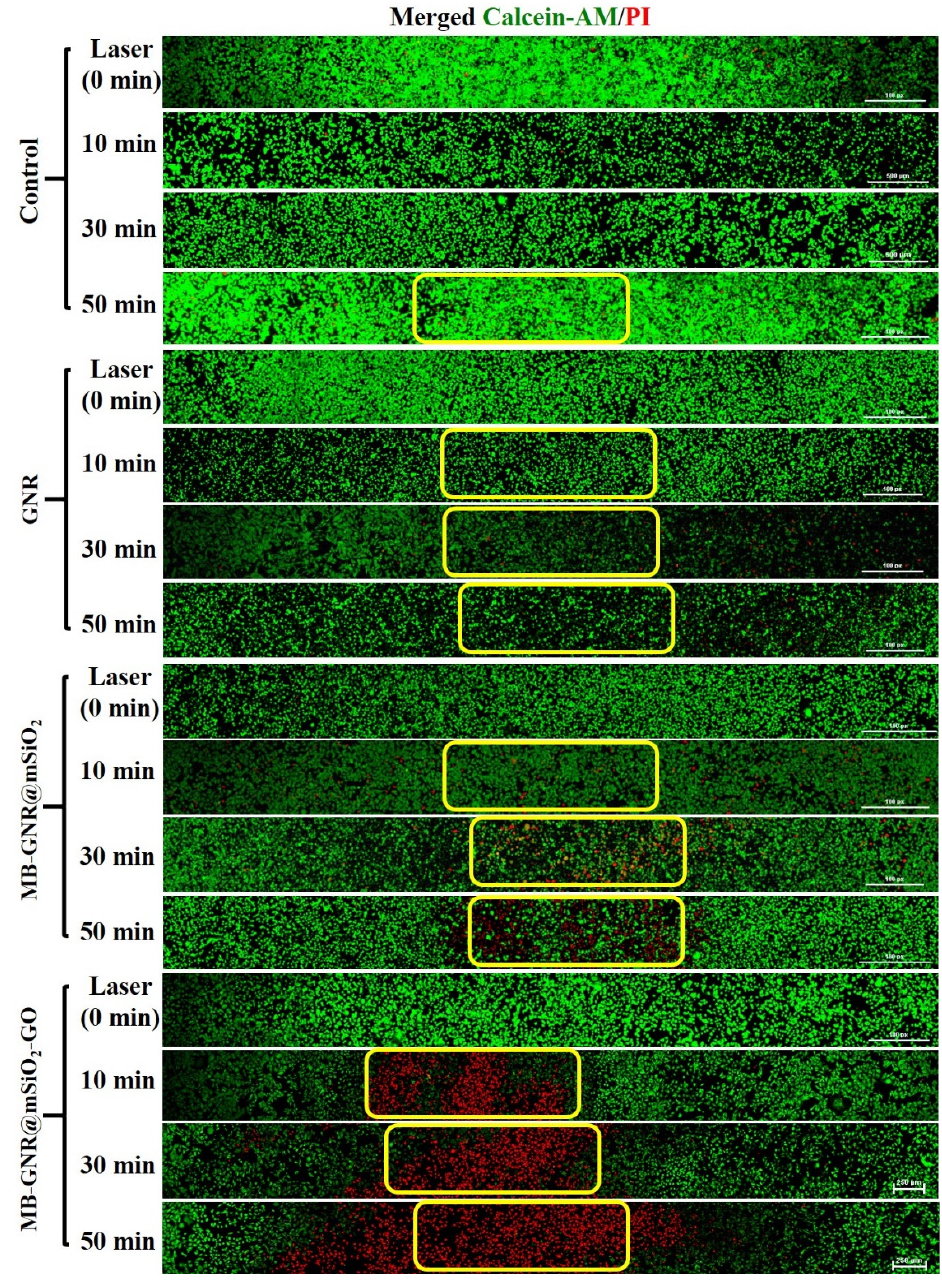
Figure 6. Merged confocal fluorescence images of MDA-MB-231 cells treated with gold nanorods (GNRs), methylene blue-loaded mesoporous silica-coated gold nanorods (MB-GNR@mSiO 2 ), and methylene blue-loaded mesoporous silica-coated gold nanorods on graphene oxide (MB- GNR@mSiO 2 -GO) (200 µ L of 36 µ g/mL) for 12 h with or without 785 nm laser irradiation at 0.8 W/cm 2 for various time points (0, 10, 30, and 50 min). The cells were stained using calcein- AM (live: green) and PI (dead: red) (20 × magnification). The yellow color indicates the laser spot